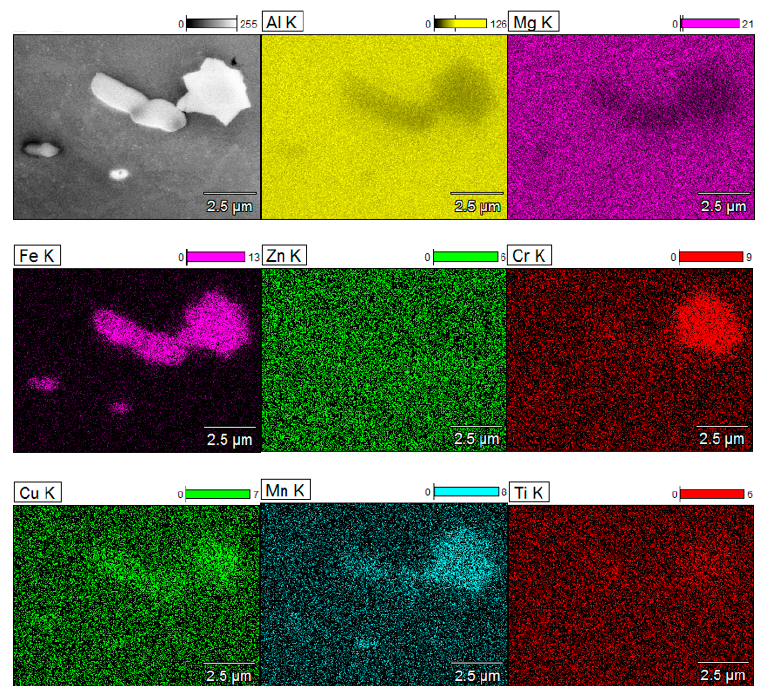
Figure 6. EDS mapping results of inclusions within AA 7075.